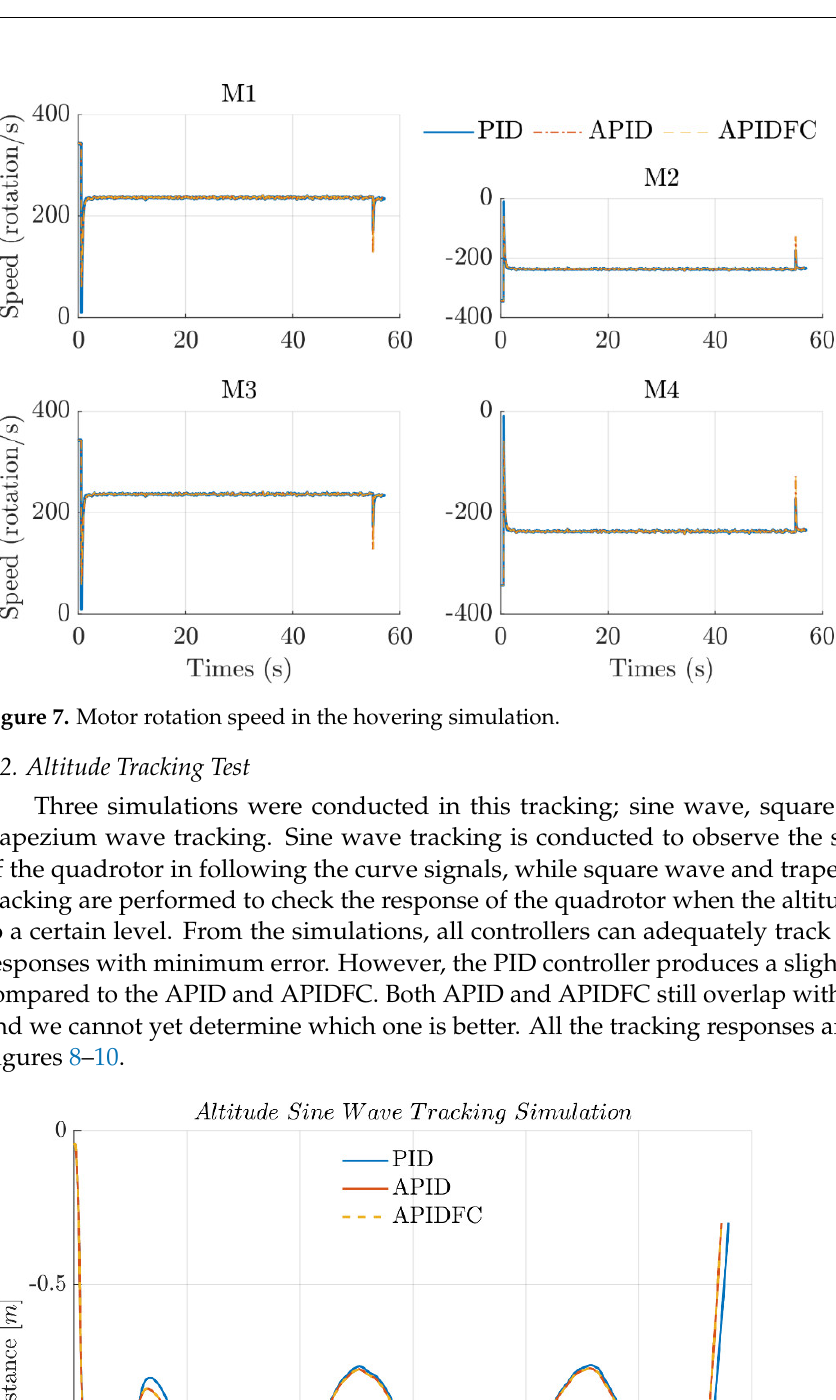
Figure 6. Hovering simulation.